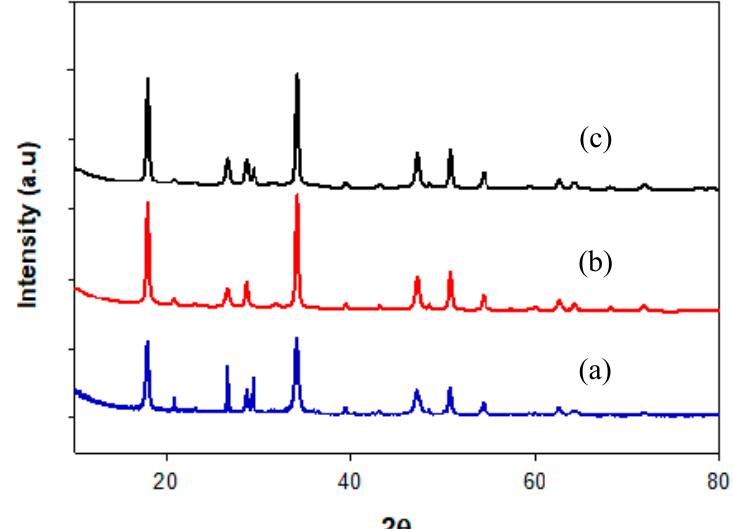
Figure 1. X-ray di ff raction (XRD) pattern of the calcium oxide (CaO) / palm mill fly ash (PMFA) catalysts, Figure 1. X-ray diffraction (XRD) pattern of the calcium oxide (CaO)/palm mill fly ash (PMFA)